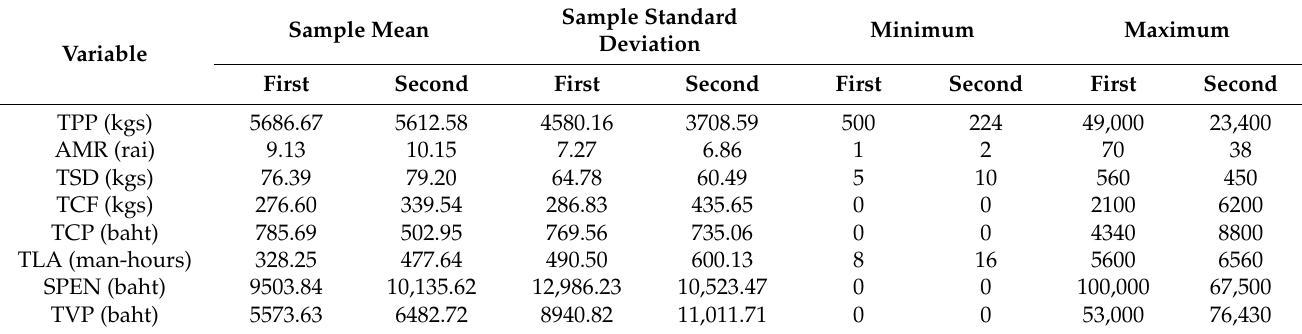
Table 3. Summary statistics of key variables for major rice farmers in first group and second group.